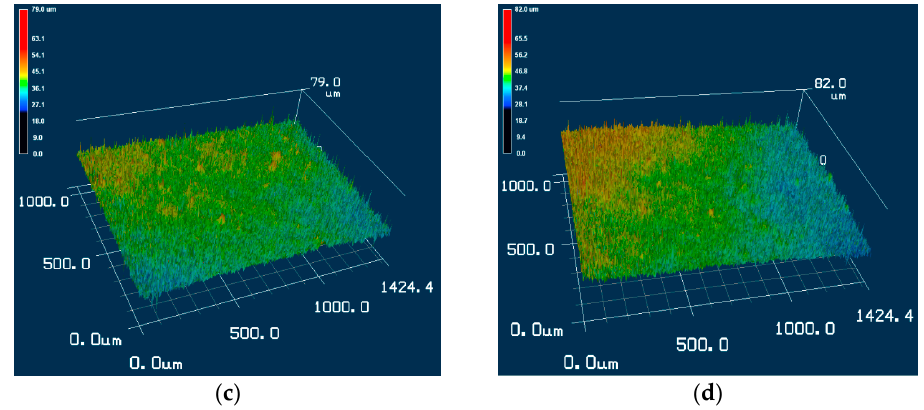
Figure 10. Series of CLSM photographs of the cathode surface with various sintering temperatures: ( a ) 1100 °C; ( b ) 1150 °C; ( c ) 1200 °C; and ( d ) 1250 °C.